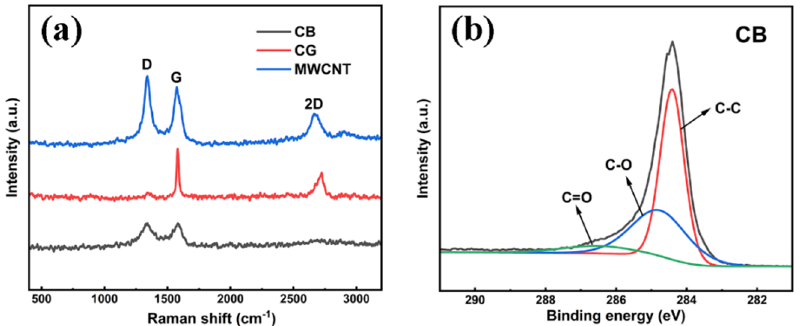
Figure 1. ( a ) Raman spectra of three carbonaceous powders; ( b ) C 1 s XPS spectra of CB.